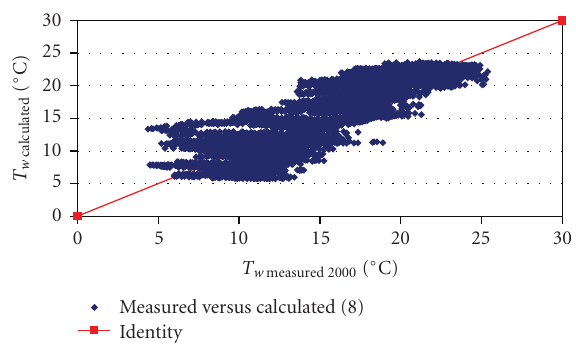
Figure 6: Comparison between measured and estimated data (8), correlation coe ffi cient r Tw , Tw 1 = 0 . 88.